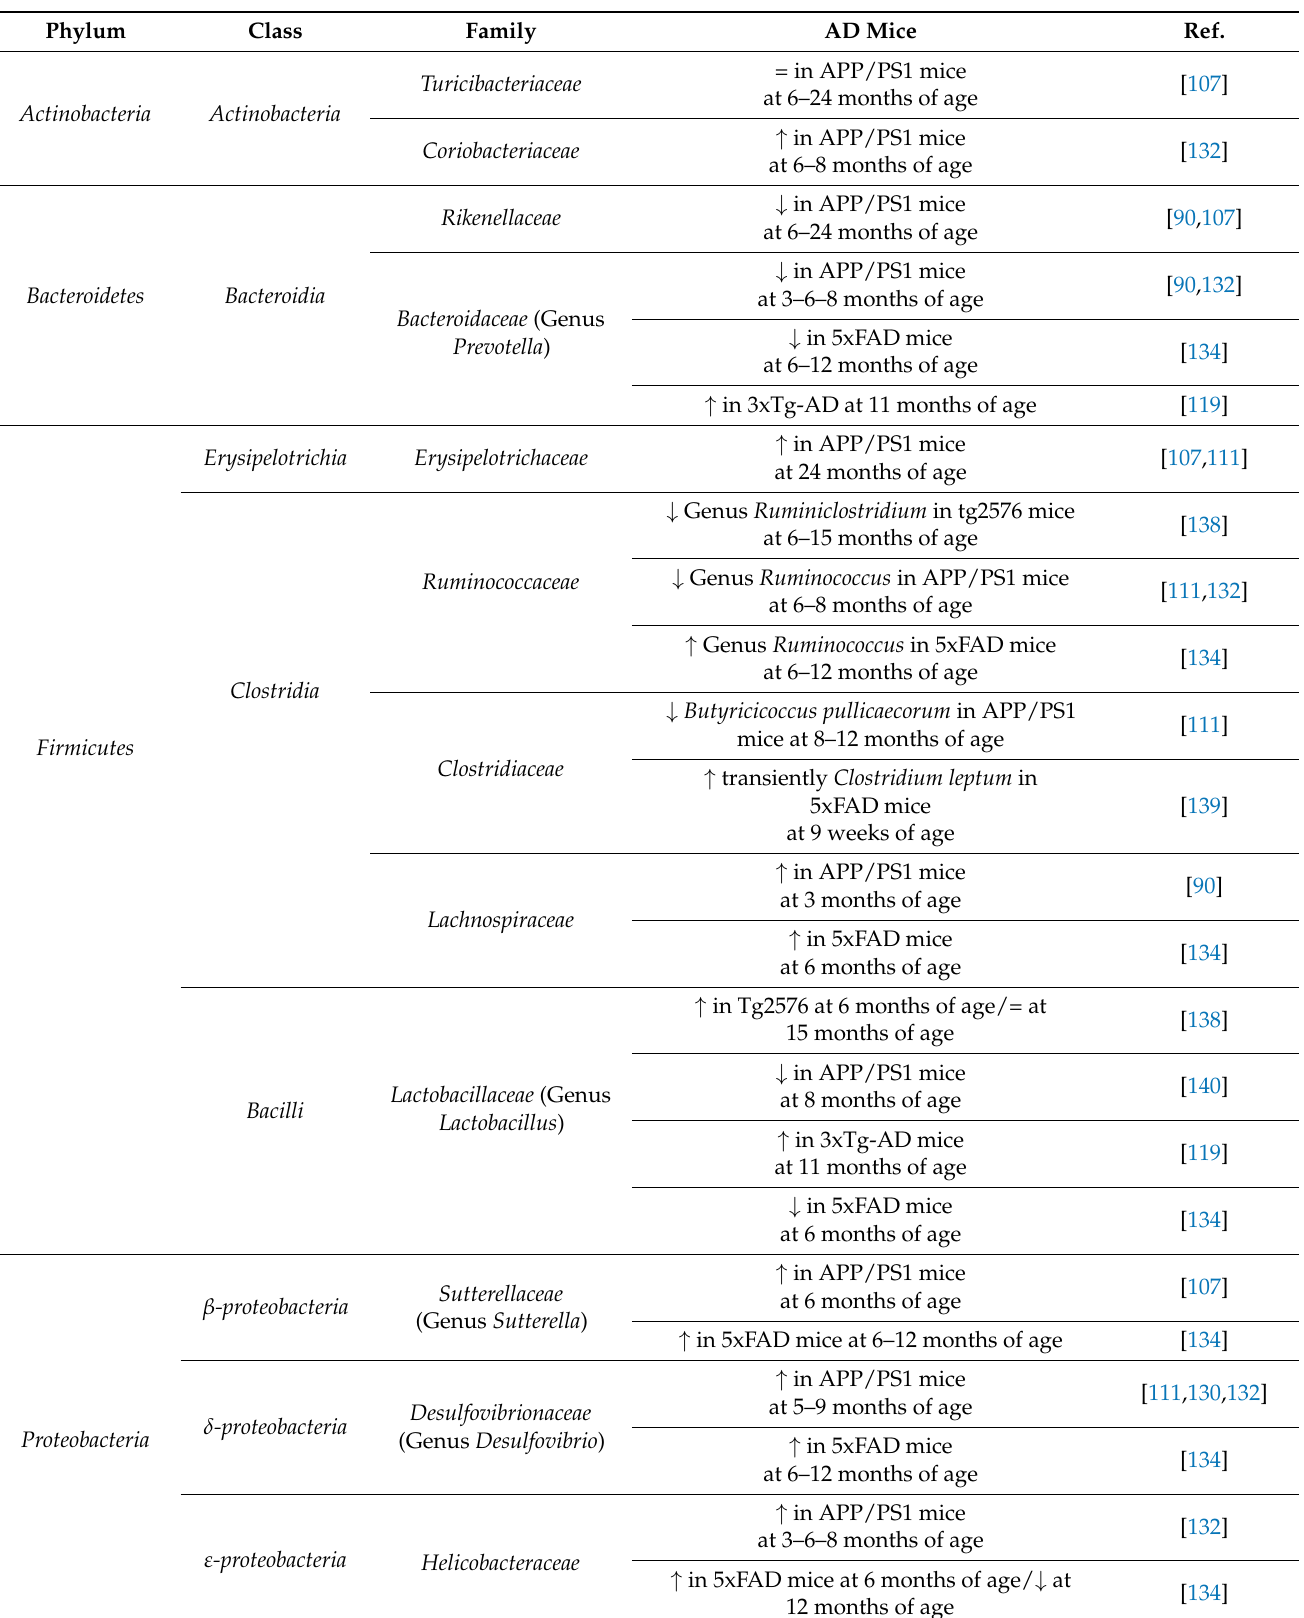
Table 1. Alterations of gut composition in AD preclinical